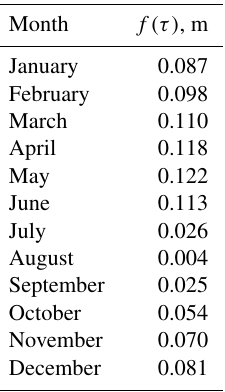
Table A1. Monthly mean values of the correction term f (τ) in Eq. (1), taken from Table 4 in Rothrock et al. (2008).